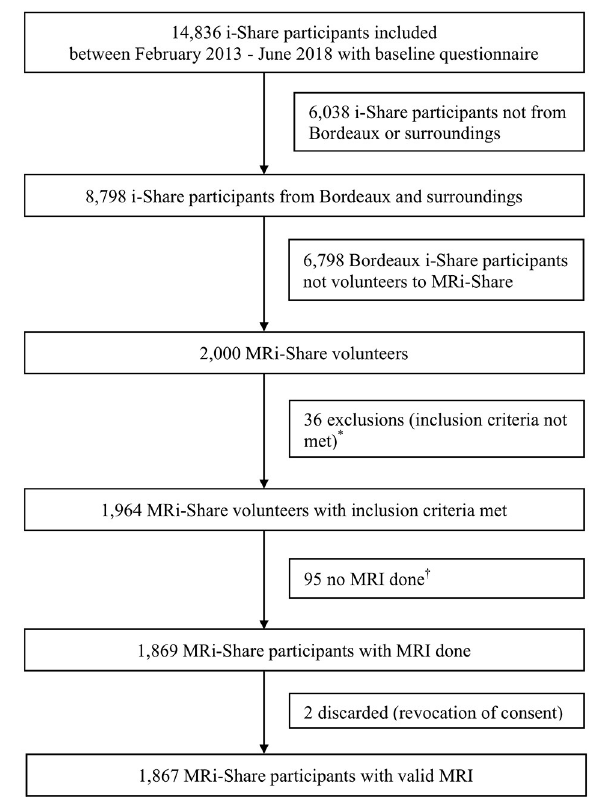
FIGURE 1 | MRi-Share flow diagram. *Age criteria not met, n = 4; baseline questionnaire not completed, n = 1; presence of contra-indications to MRI, n = 16 (metal fragments or devices, n = 3; claustrophobia, n = 4; others, n = 9); others, n = 15. † Drop-out, n = 54; study termination, n =